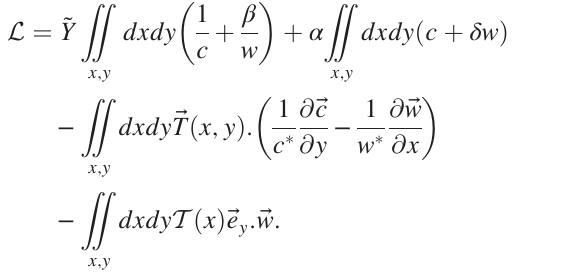
fields are slowly varying functions in space, only terms that are linear in their first spatial derivatives are retained.